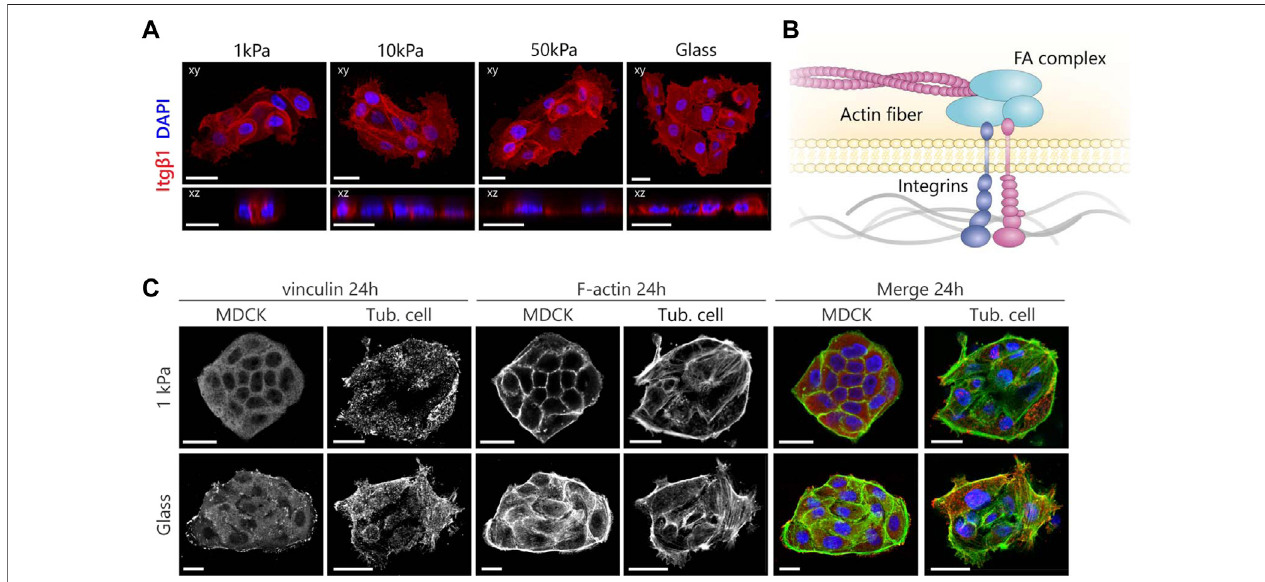
FIGURE4| MDCKsandtubuloid-derivedcellsshowadifferentorganizationofthemechanosensingmachineryaccordingtosubstratestiffness. (A) Representative fl uorescent images of β 1 integrin expression in tubuloid-derived cells cultured on substrates for 24 h with variable elastic moduli. Cells were stained for β 1 integrin (red) and nuclei(blue). (B) Agraphicalillustration displaying themechanotransductionpathway that acts viathe dynamic link the FA complexforms betweenintegrins and the actin cytoskeleton. (C) Immuno fl uorescence images displaying the differences in maturation and organization of the focal adhesions in red (vinculin) and the cytoskeleton in green (F-actin) after 24 h. Scale bars are 20